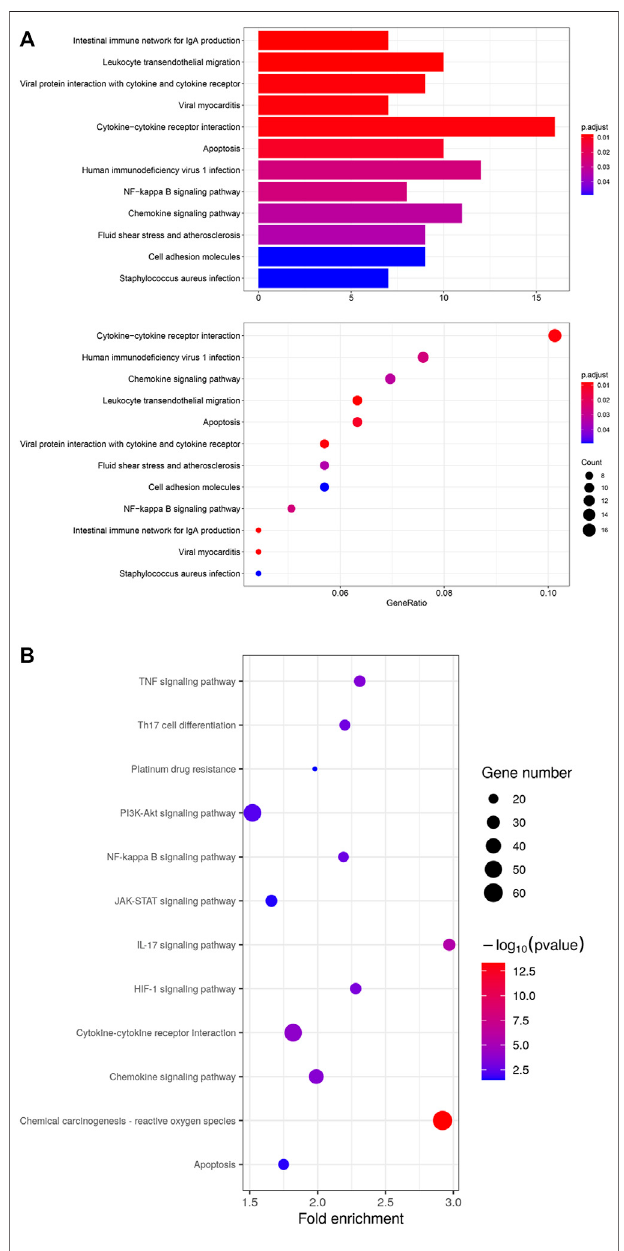
FIGURE 6 | (A) KEGG analysis of 12 signi fi cant functional pathways in epithelial cells of residual tumor. (B) KEGG analysis of 12 selected pathways out of 81 signi fi cant pathways in CAFs of residual